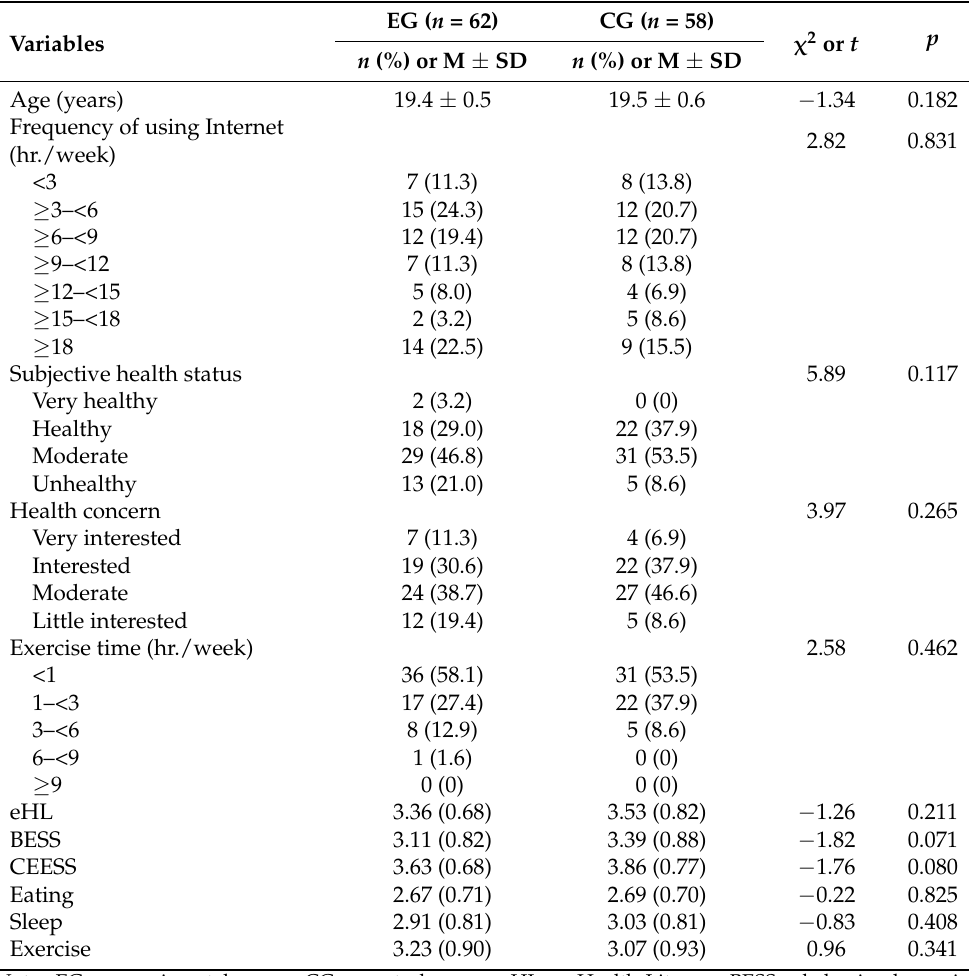
Table 2. Participant characteristics and homogeneity test ( n =